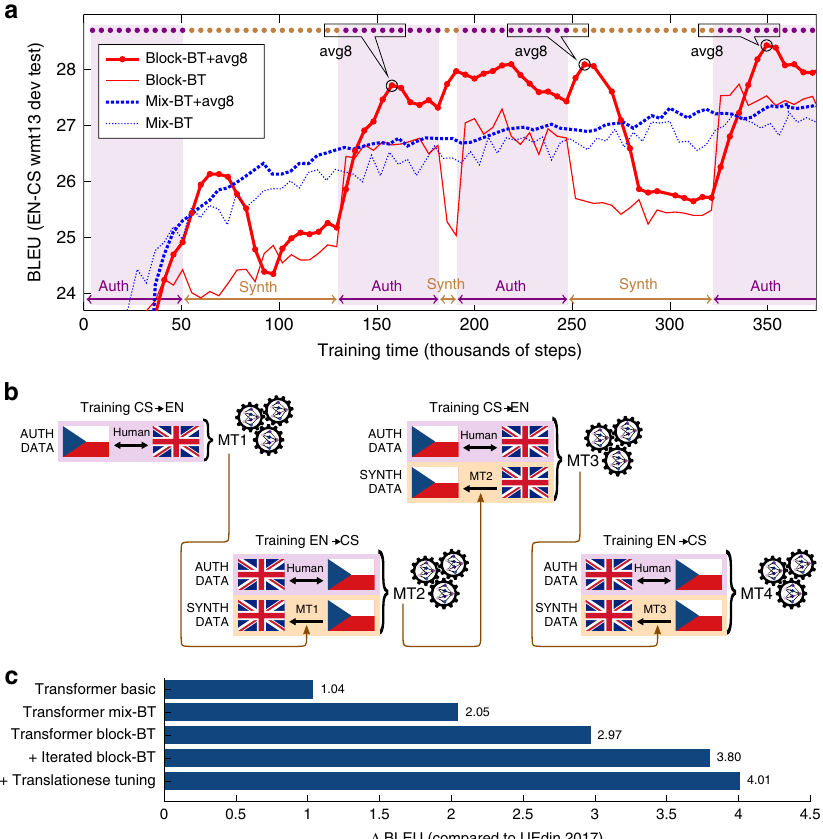
Fig. 2 Backtranslation technique used in CUBBITT. a The effect of averaging eight last checkpoints with block-BT and mix-BT on the translation quality as measured by BLEU on the development set WMT13 newstest. The callouts (pointing to the initial and fi nal peaks of the block-BT + avg8 curve) illustrate the 8 averaged checkpoints (synth-trained ones as brown circles, auth-trained ones as violet circles). b Diagram of iterated backtranslation: the system MT1 trained only on authentic parallel data is used to translate monolingual Czech data into English, which are used to train system MT2; this step can be iterated one or more times to obtain MT3, MT4, etc. The block-BT + avg8 model shown in a is the MT2 model in (B) and in Supplementary Fig. 2. c BLEU results on WMT17 test-set relative to the WMT17 winner UEdin2017. All fi ve systems use checkpoint